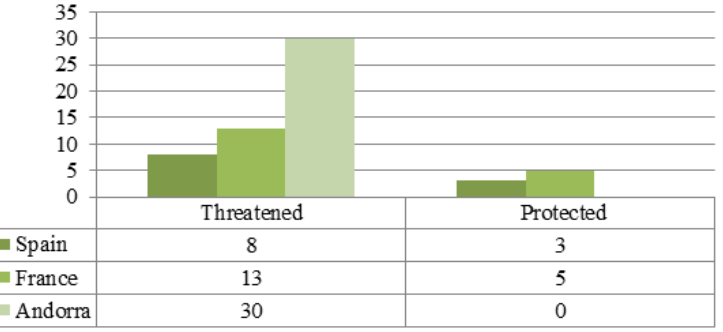
Figure 5. Number of threatened vs. protected species in any